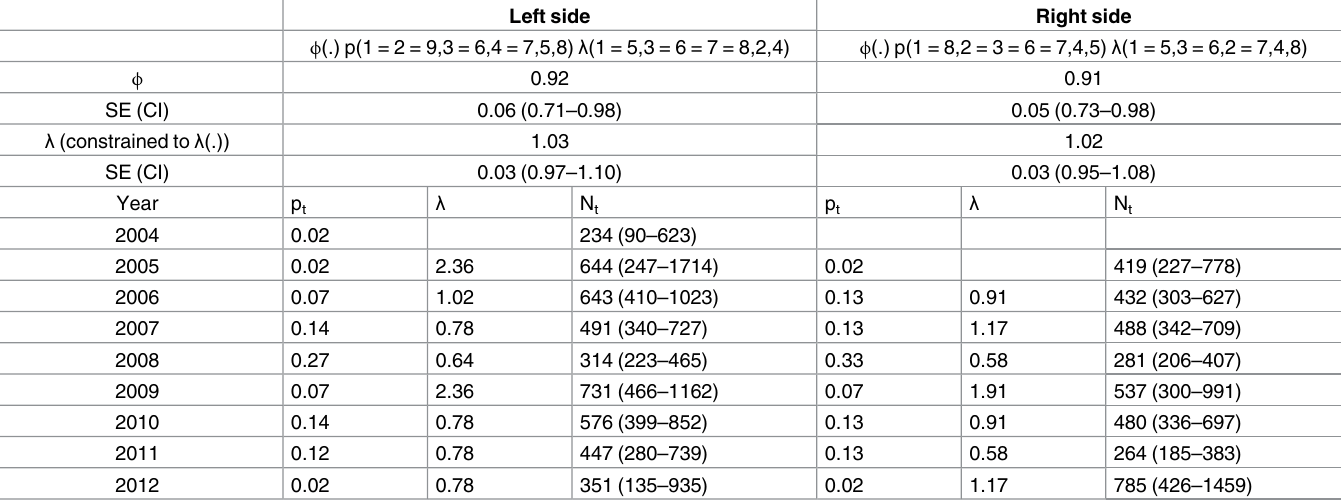
Table 3. Chilean blue whale apparent survival ( ϕ ) and apparent population growth ( λ ) for 2004–2012using the PRADEL population model. Left side Right